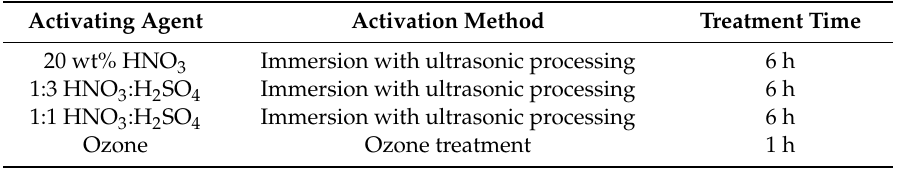
Table 3. Activation methods and treatment conditions of the PAN-derived carbon nanofiber mats. Activating Agent